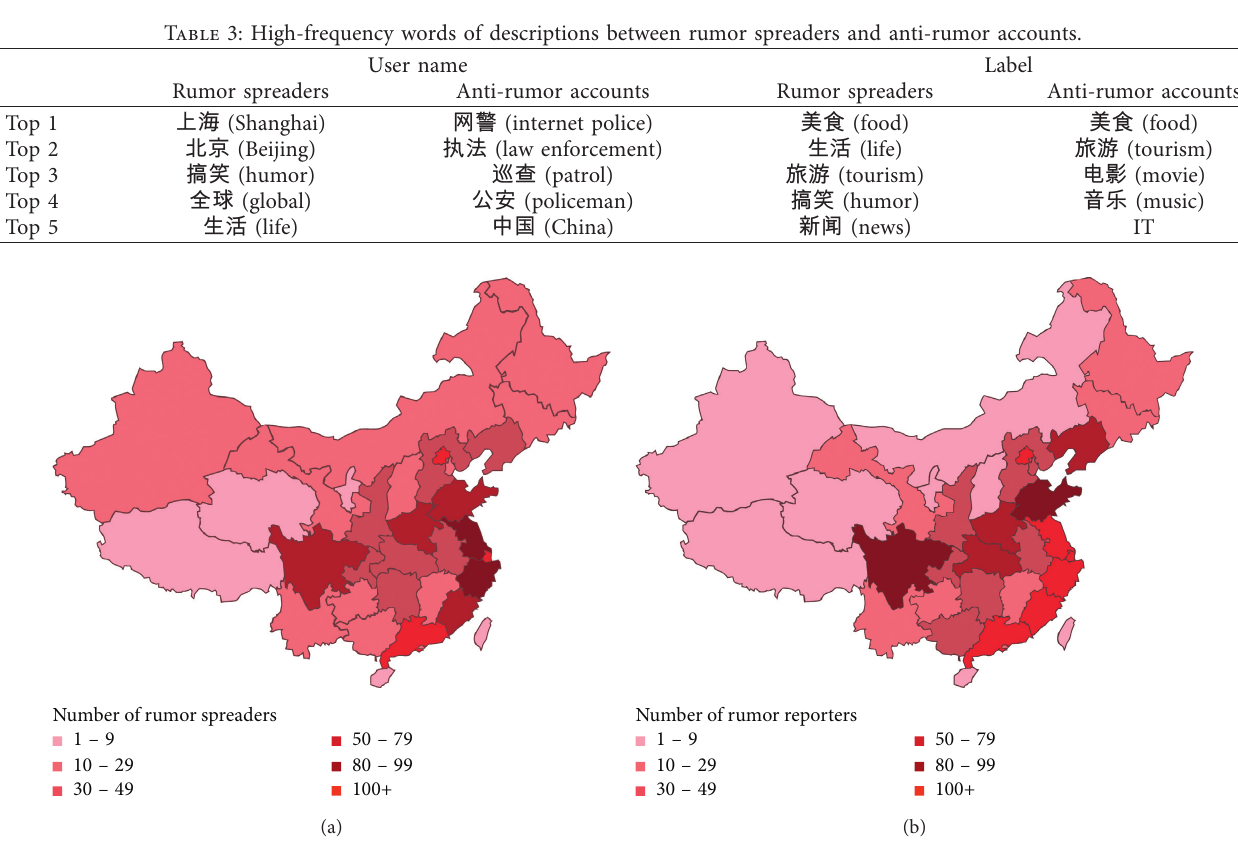
Figure 2: Geographical distributions between (a) rumor spreaders and (b) anti-rumor accounts.